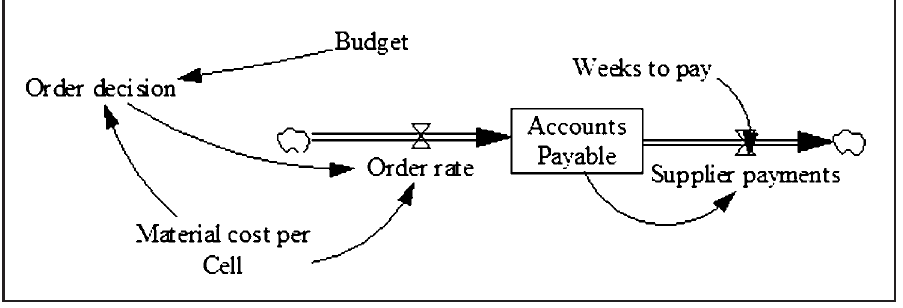
Figure 4. Accounts Receivable Sector